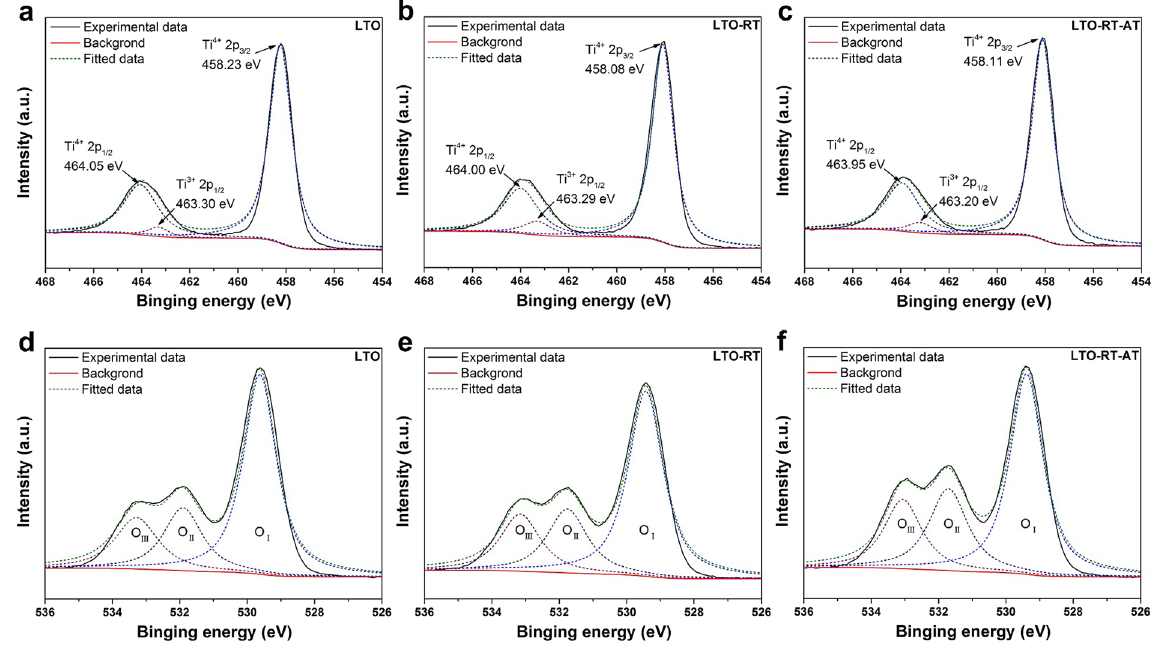
Figure 2. Ti 2p and O 1 s XPS spectra of ( a , d ) pure LTO, ( b , e ) LTO-RT and ( c , f )